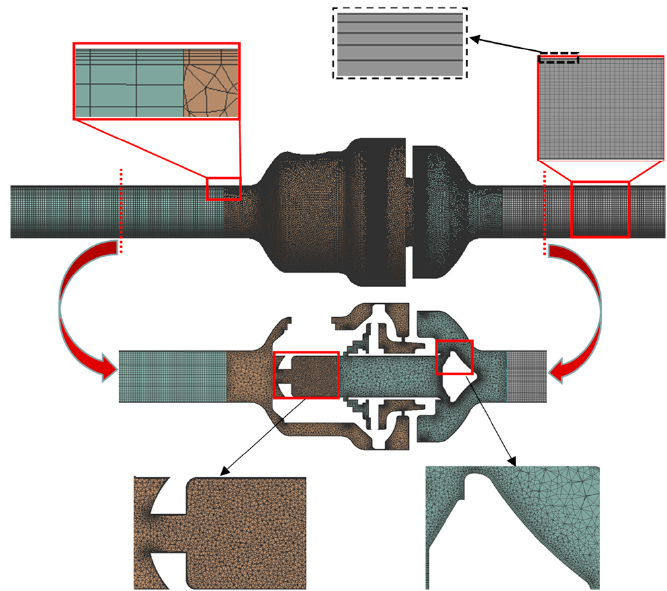
Figure 6. The division of the flow channel mesh of the valve. The boundary conditions are shown in Equation